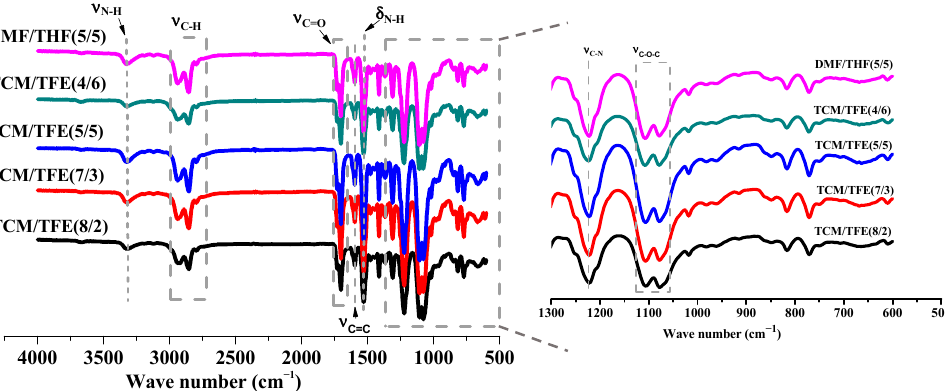
Figure 4. FT-IR spectra of TPU nanofibers from TCM/TFE and DMF/THF solvent systems.